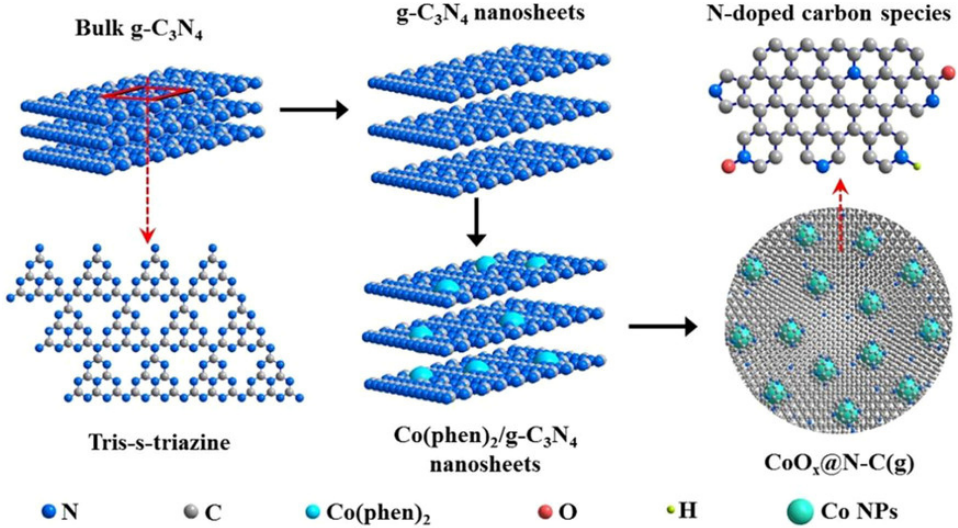
Figure 5. Schematic diagram of the synthesis process of the CoO x @N-C(g) catalyst. Reproduced with permission from [24]. Copyright: Wiley 2019. Table 2. Studies of oxidative esterification of furfural to MF over non-noble metal catalysts.